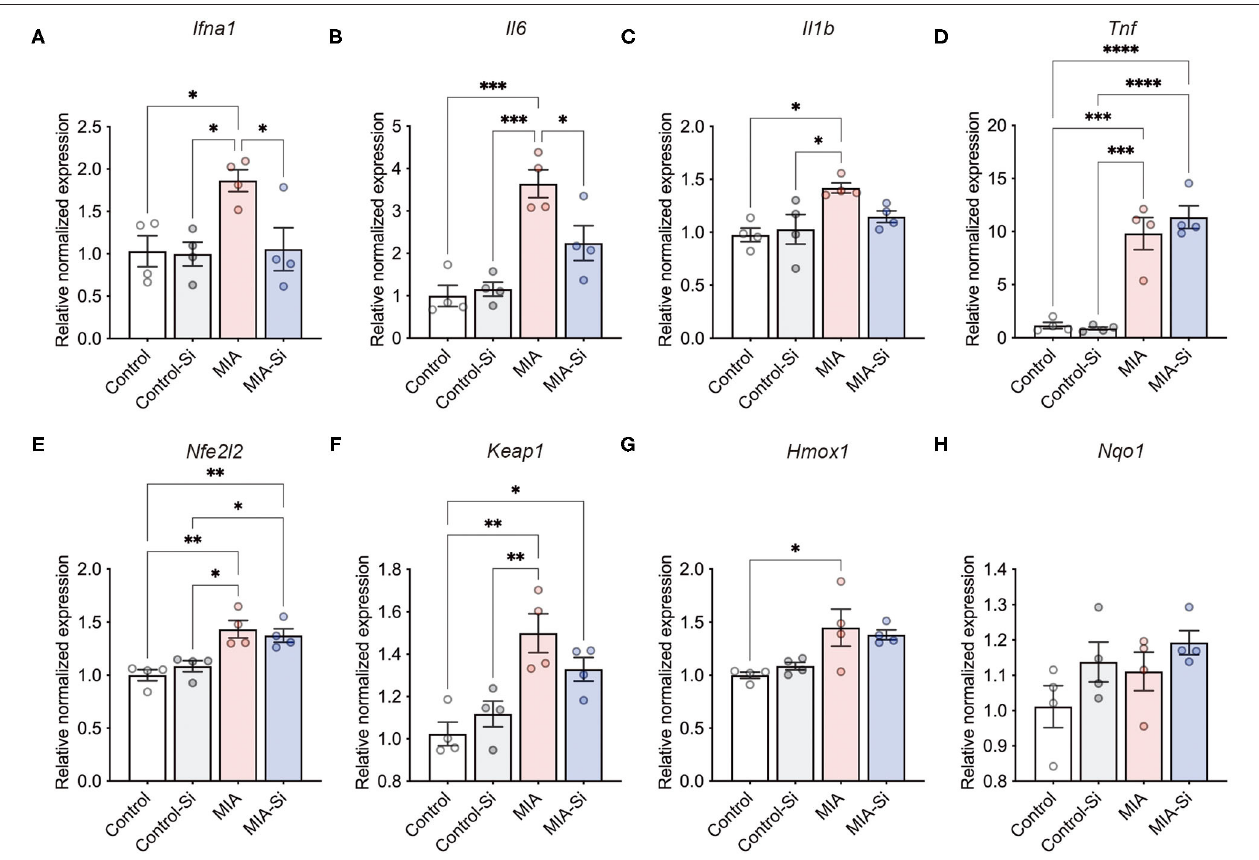
FIGURE 2 | Effects of Si-based agent on inflammatory and antioxidant system-related gene expressions. (A–D) Relative expressions of inflammatory genes ( Ifna1 , Il6 , Il1b , and Tnf ) in the mouse prefrontal cortex (PFC) at 6h after poly(I:C) injection. Inflammatory gene expressions were increased by poly(I:C) injection. In contrast, poly(I:C)-induced expressions of Ifna1 (interaction: F = 4.48, DF = 1, P = 0.06; MIA: F = 5.91, DF = 1, P = 0.0403; Si: F = 5.29, DF = 1, P = 0.0317) and Il6 (interaction: F = 6.65, DF = 1, P = 0.0242; MIA: F = 38.10, DF = 1, P = 0.06; Si: F = 4.24, DF = 1, P < 0.0001) were improved with a Si-based agent, but not